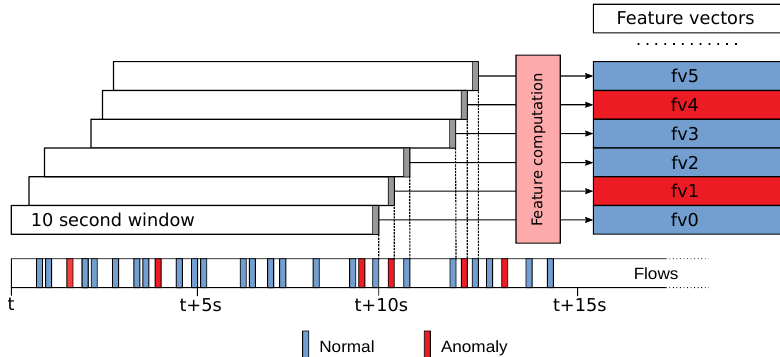
Figure 3. Feature computation. Every time a new flow arrives, the flows received during the last 10 s are used to compute the aggregated features. The feature vector is created by assembling these aggregated features plus some additional ones obtained from this last flow. The feature is labelled as anomalous only if the last flow is anomalous.